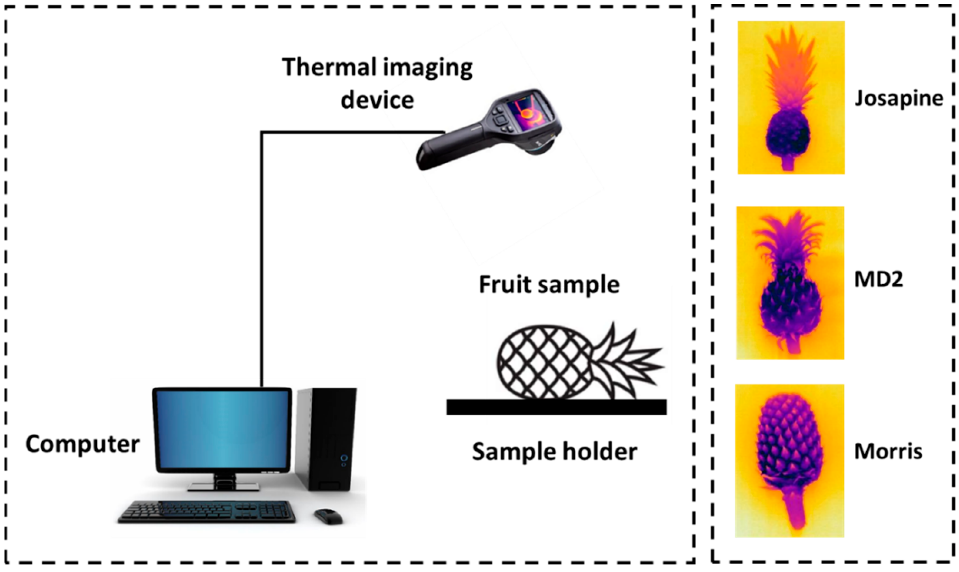
Figure 1. Schematic diagram of image acquisition using the thermal imaging system.